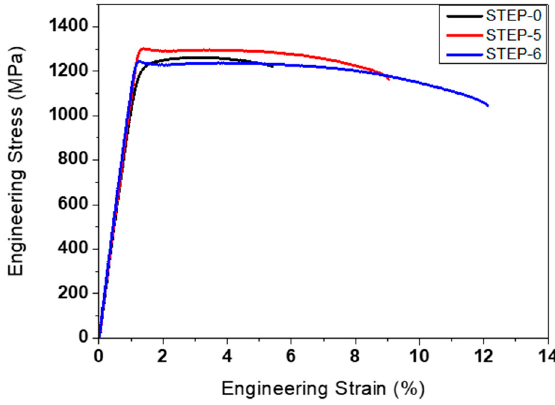
Figure 3. Engineering stress–strain curves of the investigated Ti-6Al-4V alloys at room temperature. Table 1. Room-temperature tensile properties of the investigated Ti-6Al-4V alloys.